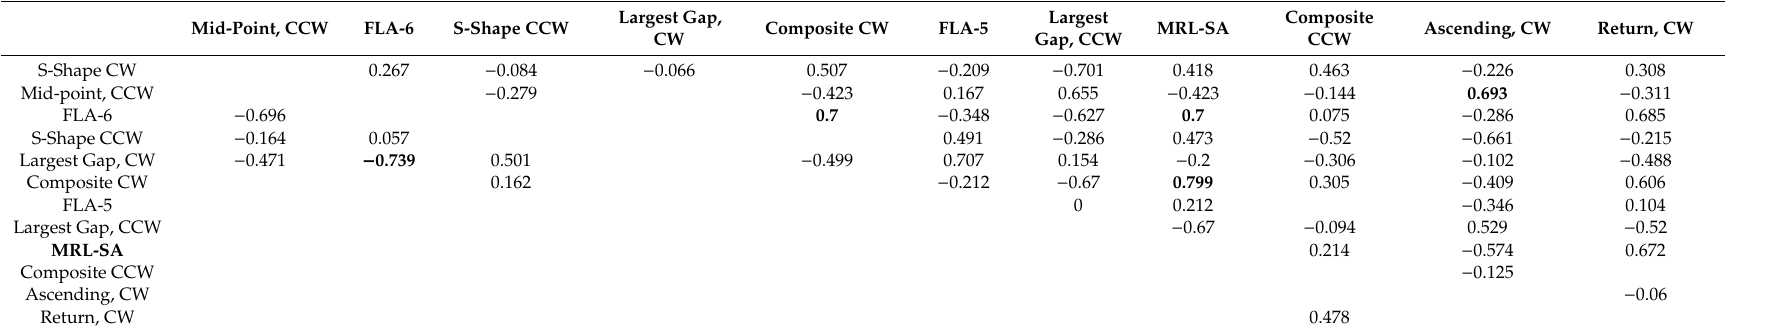
Table 5. The hybrid method correlation